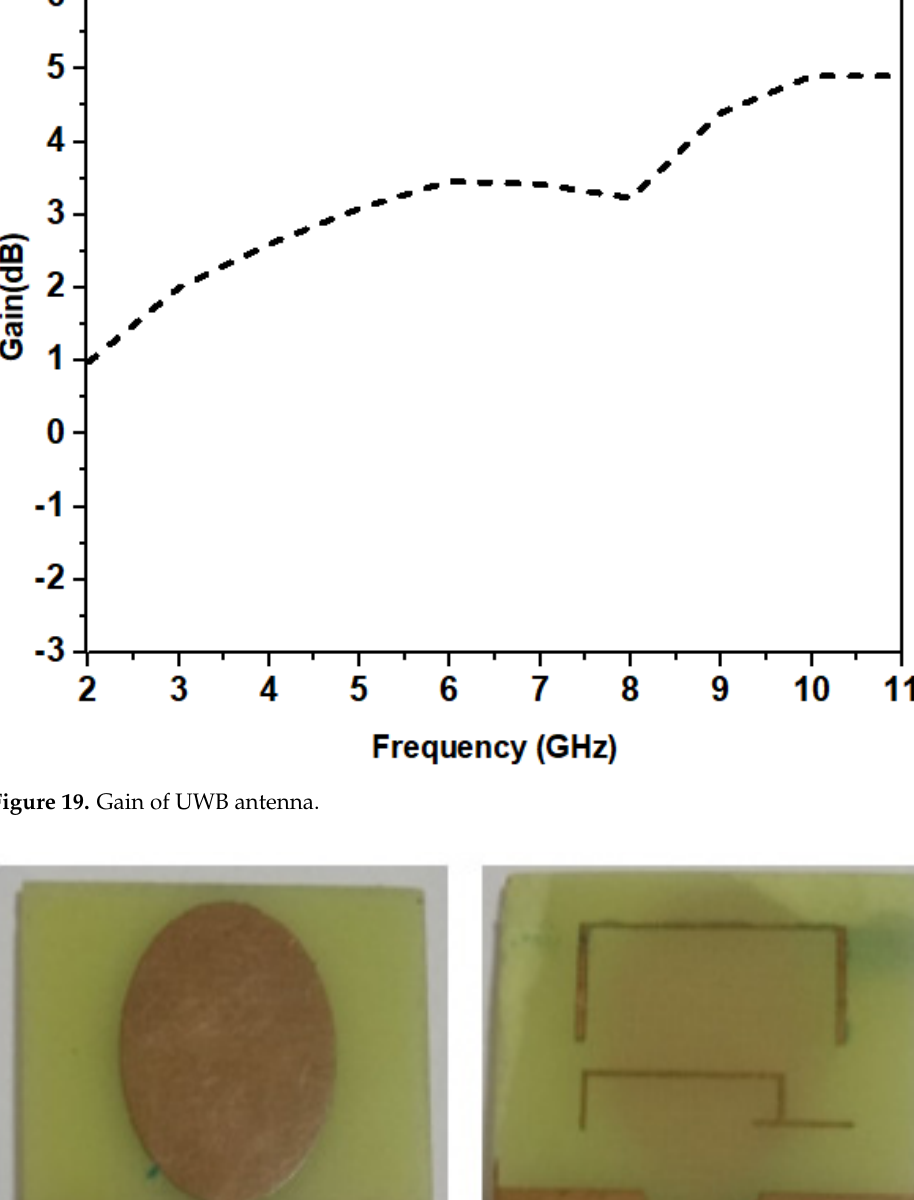
Figure 18. D gain plot at ( a ) 3.6 GHz, ( b ) 6.8 GHz, and ( c ) 9.7 GHz .